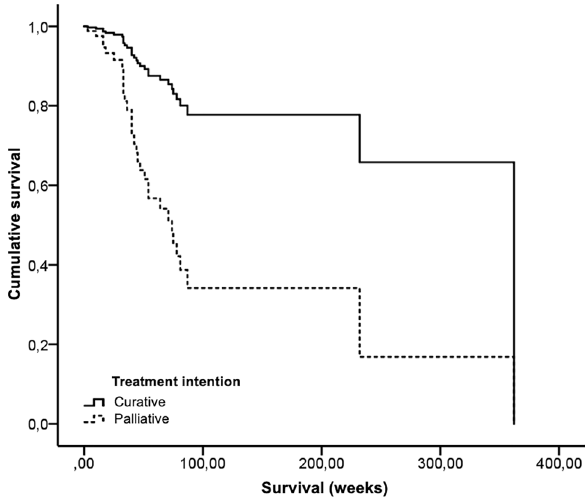
Image 7. Survival curve, in the Kaplan-Meier evaluation, relating the intention to treat with the survival of the patients, according to their weight Cox regression test, weight: p=0.828; intention to treat: p <0.001; 95% confidence interval ranging from 1.97 to 9.21 times Among patients undergoing hormone therapy, both with curative and palliative treatment intentions, there was no difference between non-obese and obese patients in terms of survival (Kaplan-Meier test – log-rank/Mantel-Cox - curative hormone therapy: p =0.175; palliative hormone therapy: p =0.077). These results are shown in Figures 8 and 9, respectively.